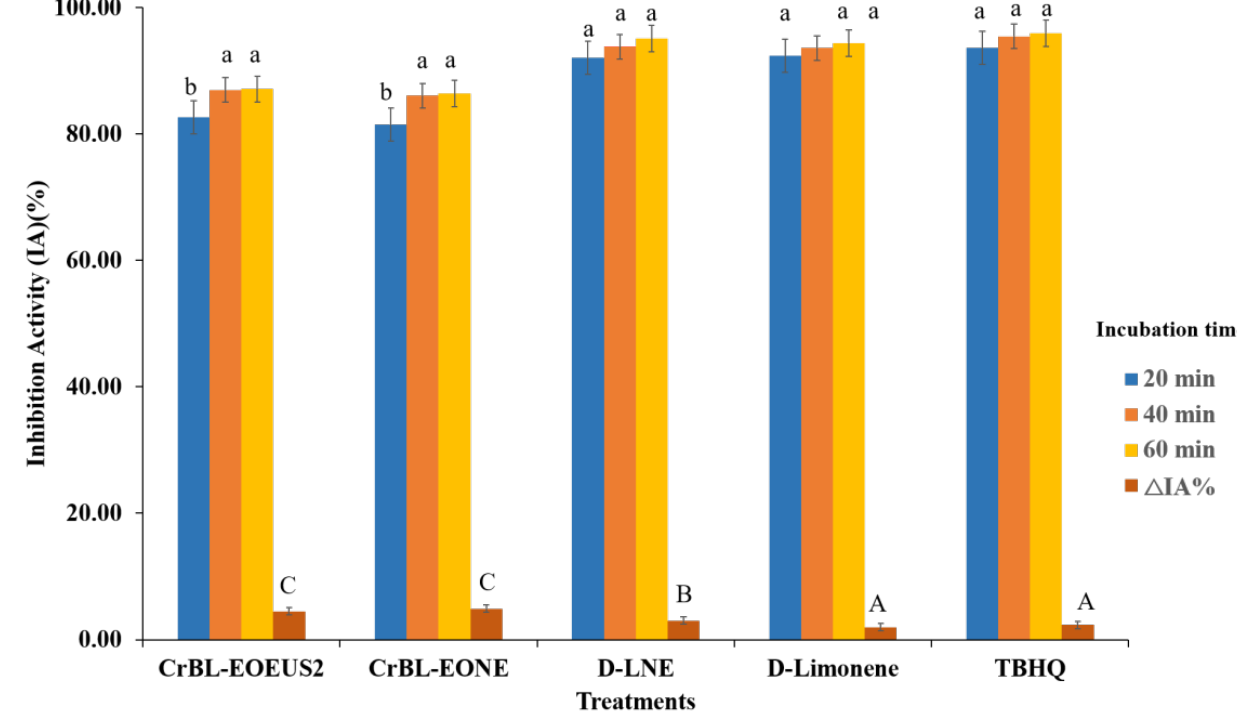
Figure 5. Inhibition activity (IA%) of the essential oil of C. reticulata with pre-enzymolysis and ultrasound–microwave treatment (CrBL-EO EUS2 ), C. reticulata essential oil nanoemulsion (CrBL- EONE), D-limonene nanoemulsion (D-LNE), D-limonene, and TBHQ in the β -carotene color in the coupled system ( β -CLE). Bars bearing the same lowercase letters indicate no significant differences in the treatments during a unit of time (20, 40, 60 min). In comparison, bars bearing the same capital letters indicate no significant differences in the ∆ IA% between the treatments. The bleaching rate of the coupled β -CLE system was measured using the colorimetric method based on the optical density (470 nm) during 60 min of the total incubation time (Figure 6). The bleaching rate curves show a decrease in the optical density (470 nm) values in the presence of CrBL-EO EUS2 , CrBL-EONE, D-LNE, D-Limonene, and TBHQ of the coupled system of β -CLE. The curves in Figure 6 show that the control treatment was less resistant and efficient in maintaining the color of β -carotene in the coupled system of β